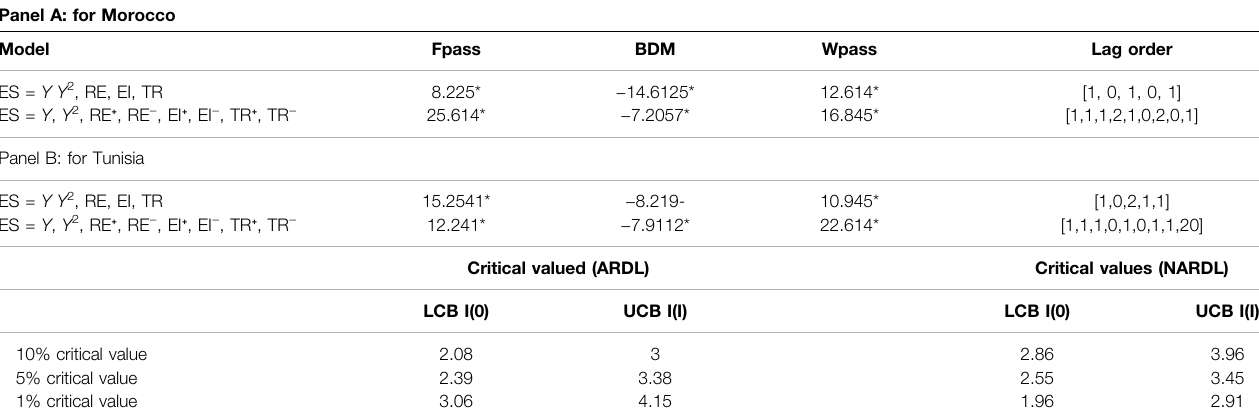
TABLE 7 | Symmetry and asymmetry cointegration